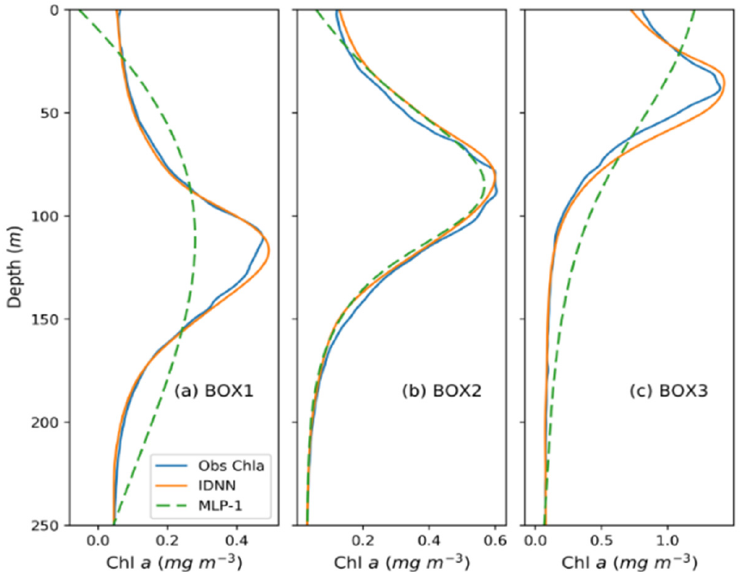
Figure 10. Comparisons of the mean profiles of observed values (blue line), IDNN predictions (or- ange line), and MLP-1 predictions (green dash line) inferred from remote-sensing data in three BOXes ( a–c